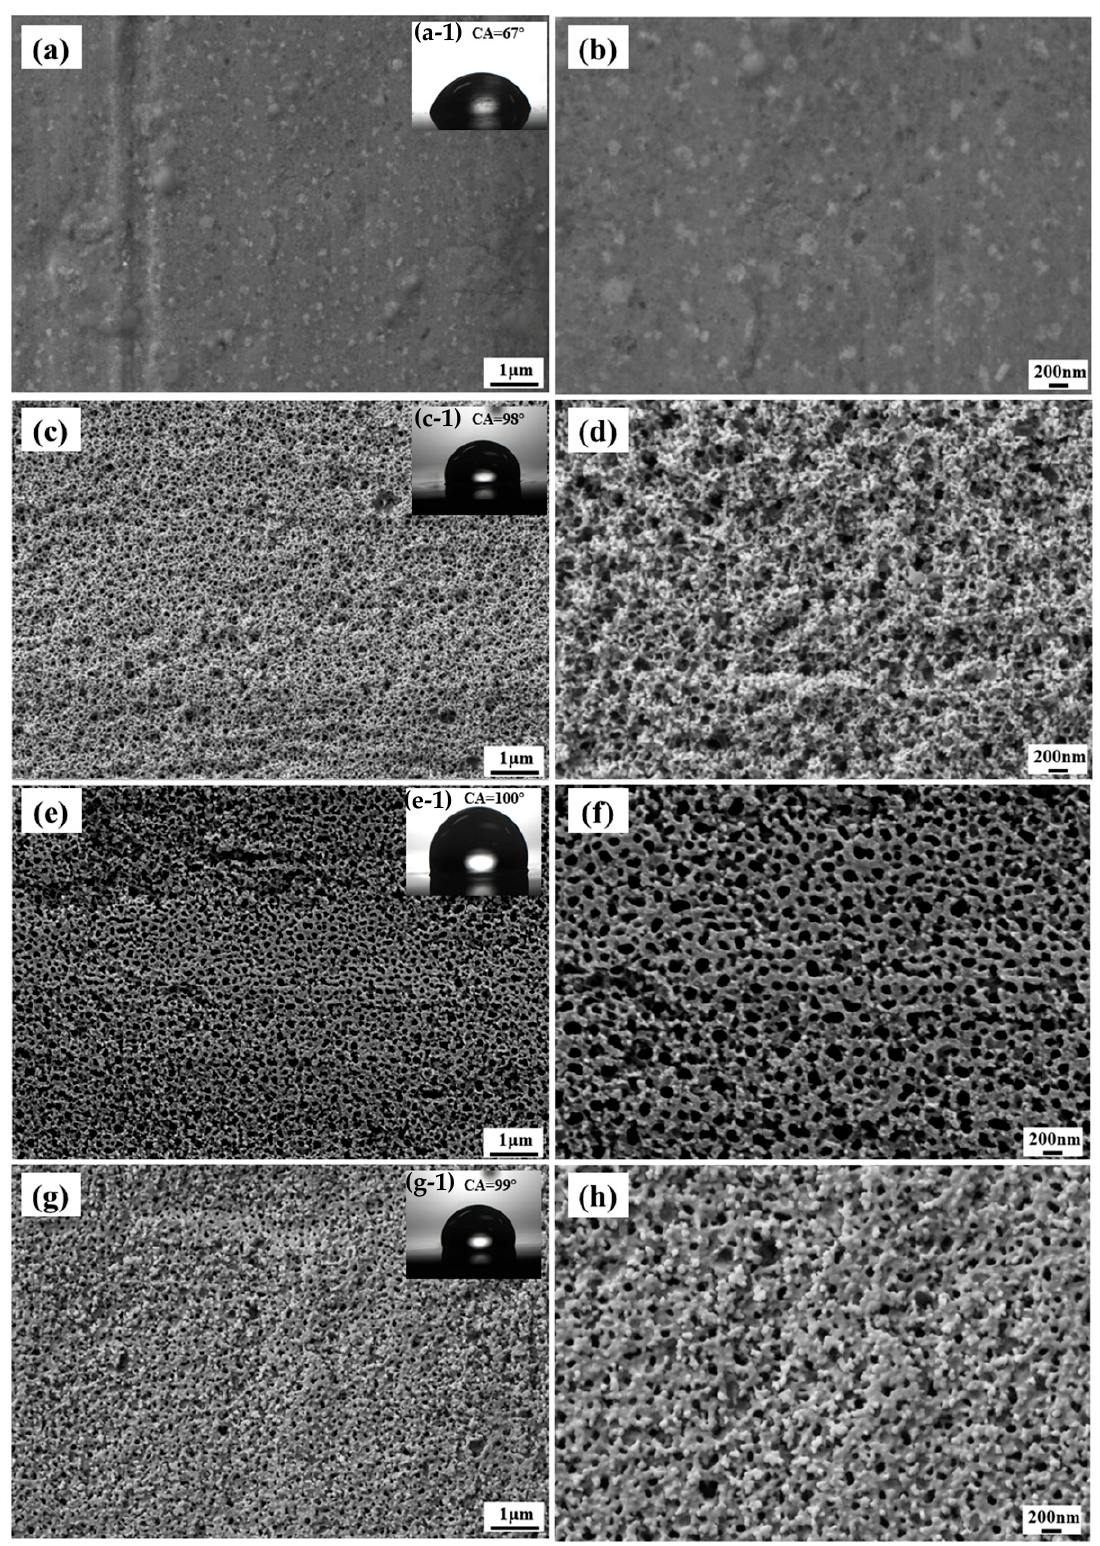
Figure 1. ( a , b ) The micromorphology of bare surface, ( c , d ) the micromorphology of SLIPS1, ( e , f ) the micromorphology of SLIPS2, ( g , h ) the micromorphology of SLIPS3; ( a–1 , c–1 , e–1 , g–1 ) exhibited CA of bare surface, SLIPS1, SLIPS2 and SLIPS3, respectively. SLIPS, slippery liquid infused porous surfaces.